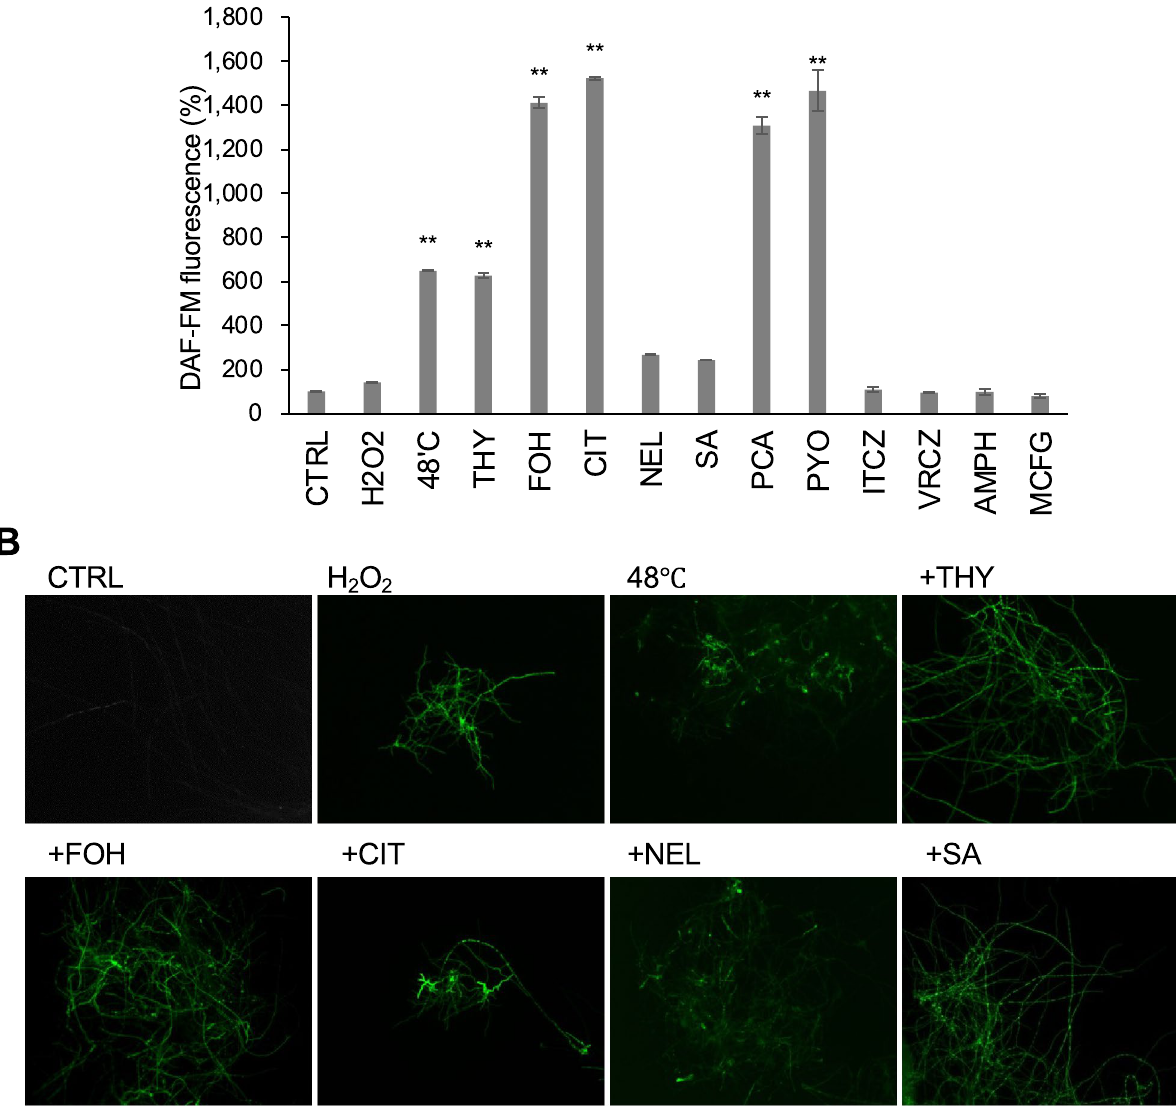
Figure 2. NO production in A. fumigatus hyphae in response to antifungal treatments. ( A ) Intracellular NO production, as indicated by DAF-FM DA, was quantified. CTRL indicates the control sample without any stressors. The fluorescence intensity per protein amount of CTRL was defined as 100%. The cells were disrupted, and the extracts were used for fluorescence intensity measurement. The value was obtained from three replicates, and the error bar represents the standard deviation. H2O2: 10 mM hydrogen peroxide, THY: 1 mM thymol, FOH: 1 mM farnesol, CIT: 1 mM citral, NEL: 1 mM nerol, SA: 1 mM salicylic acid, PCA: 1 mM phenazine-1-carboxylicacid, PYO: 1 mM pyocyanin, ITCZ: 10 µg/mL itraconazole, VCZ: 10 µg/mL voriconazole, AMPH: 10 µg/mL amphotericin B, and MCFG: 10 µg/mL micafungin. Significant differences compared with the CTRL sample were examined using Dunnett’s tests and are indicated as * p < 0.05; ** p < 0.01. ( B ) Intracellular NO was visualised using DAF-FM DA and a fluorescence microscope. The cells were treated in the same way for the fluorescence intensity